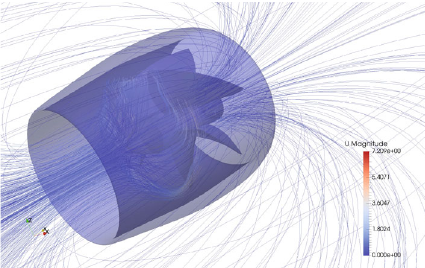
Figure 18: Streamlines in bollard pull mode in the absence of a stator at 600